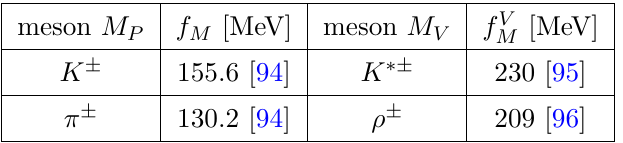
Table 3 . Decay constants for charged pseudoscalar and vector